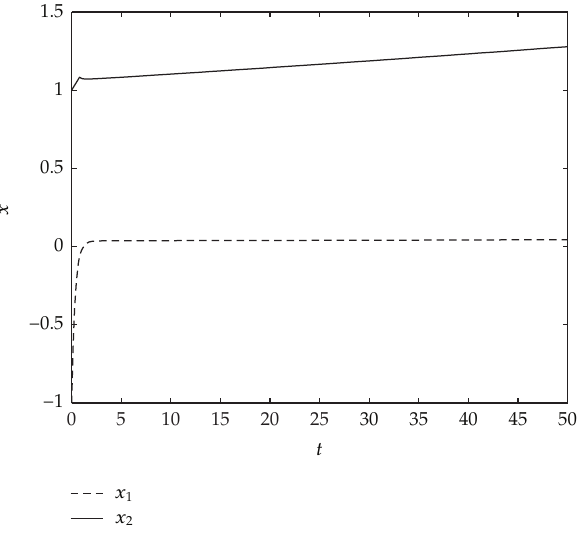
Figure 6: The trajectory of solution of system i (cid:8)